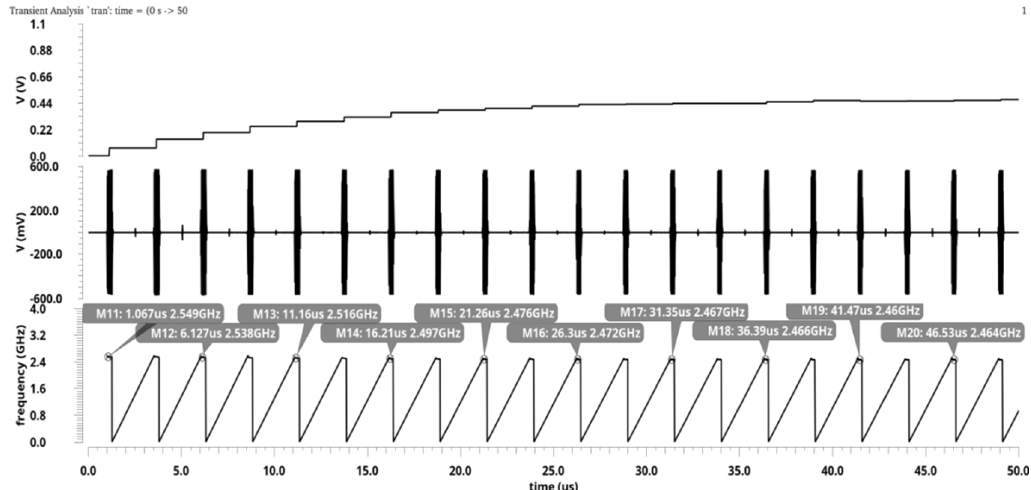
Figure 19. The simulation results of the proposed background frequency calibration, sequentially including: the control voltage, SRO’s output signal, and the frequency calibration results (the calibration results in each quenching cycle have been labeled).